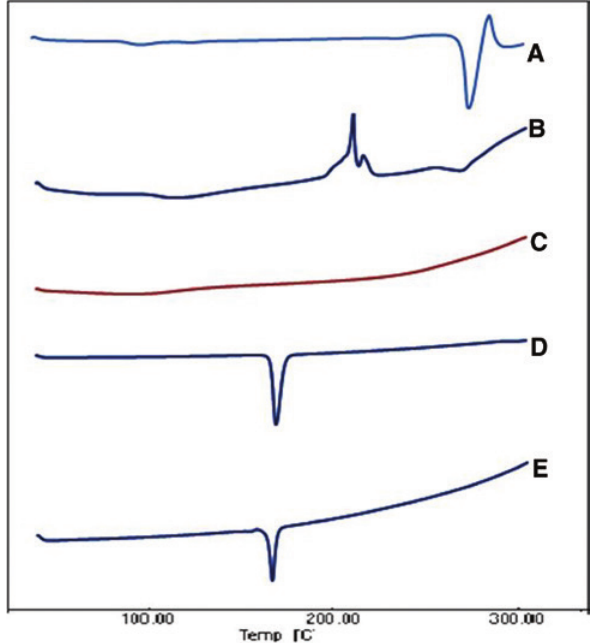
Figure 5: DSC of (A) drug, (B) DS, (C) CS, (D) mannitol, and (E)